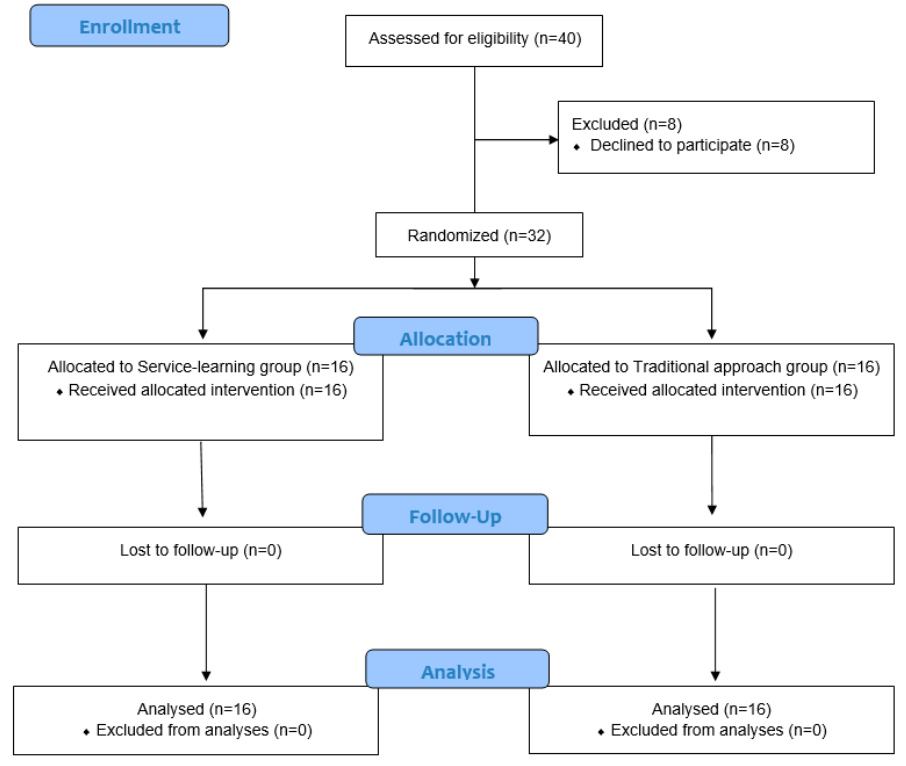
Figure 1. Flow diagram according to CONSORT statement for the report of randomized trial. Table 1. Participants characteristics.